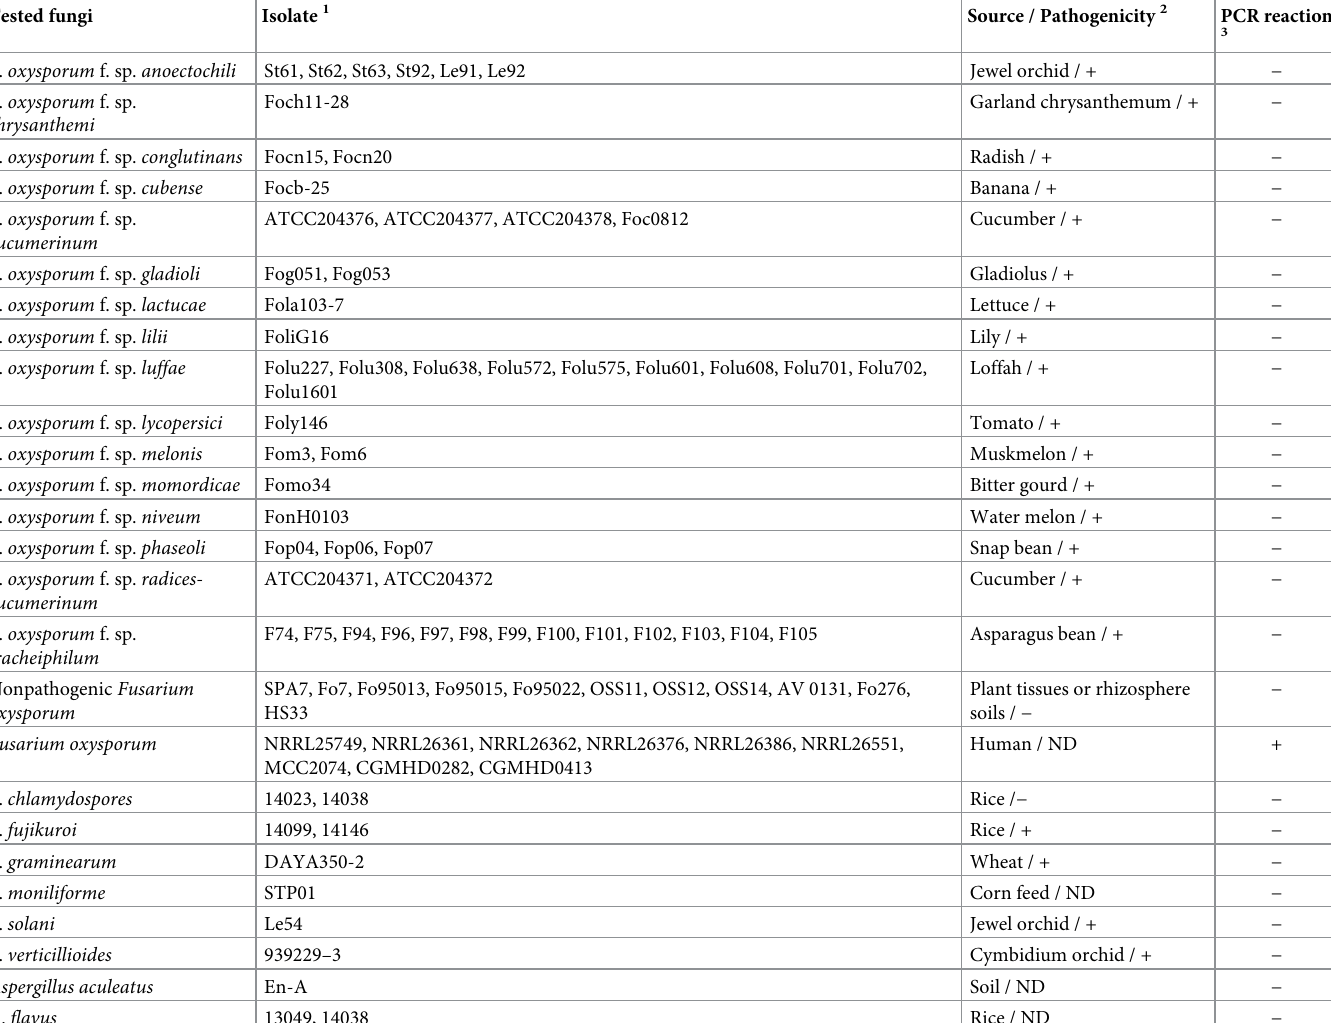
Table 1. Name, formae speciales, isolation source, pathogenicity and PCR reaction with Primer 5/ST33-T of Fusarium oxysporum , Fusarium spp. and other fungi used in this study. Tested